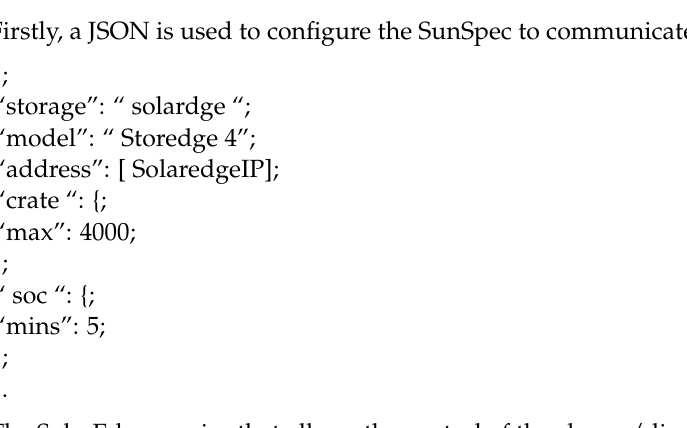
Figure 13. The 4 kW-4 kWh SolarEdge ba tt ery storage.